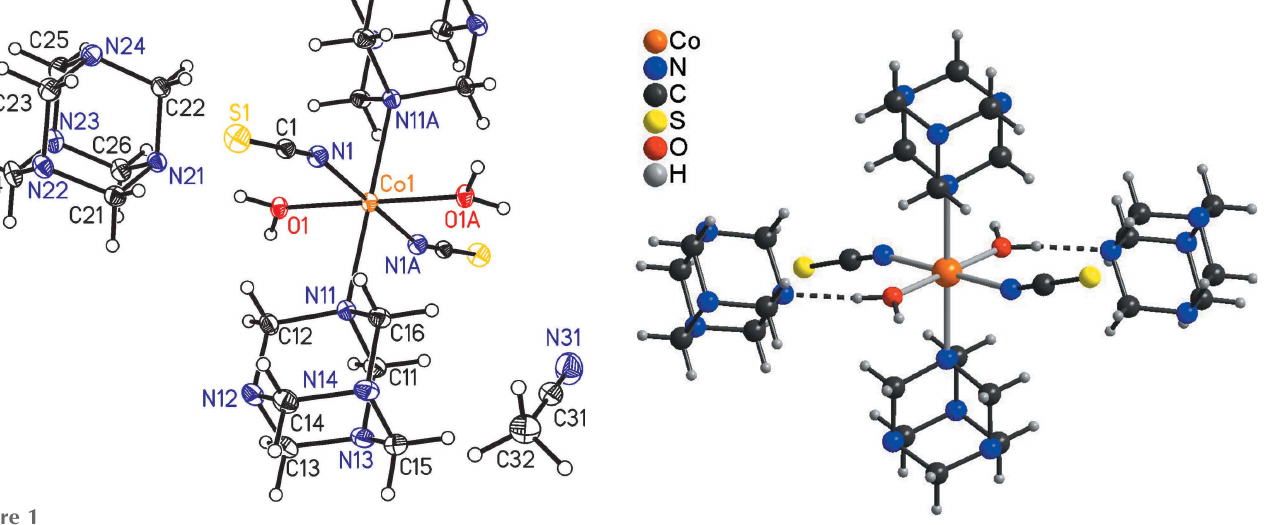
Figure 2 View of a discrete complex that is connected to two hexamethyl-